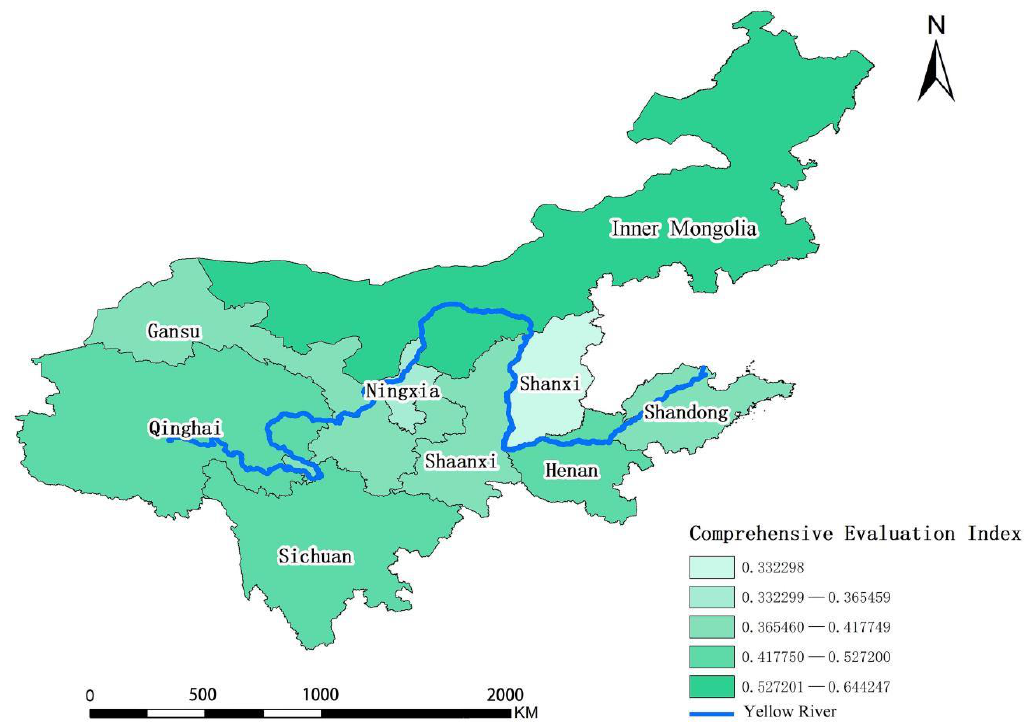
Figure 3. Comprehensive evaluation